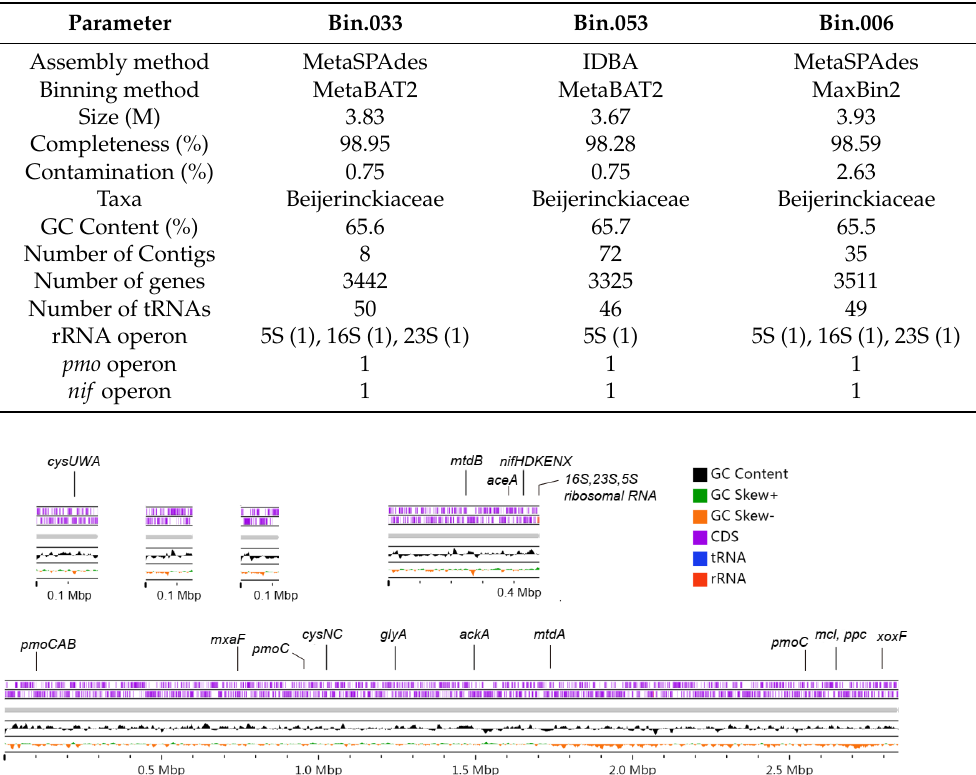
Table 1. Genome statistics of the obtained three metagenome-assembled genomes (MAGs) of lin- eage MO3.